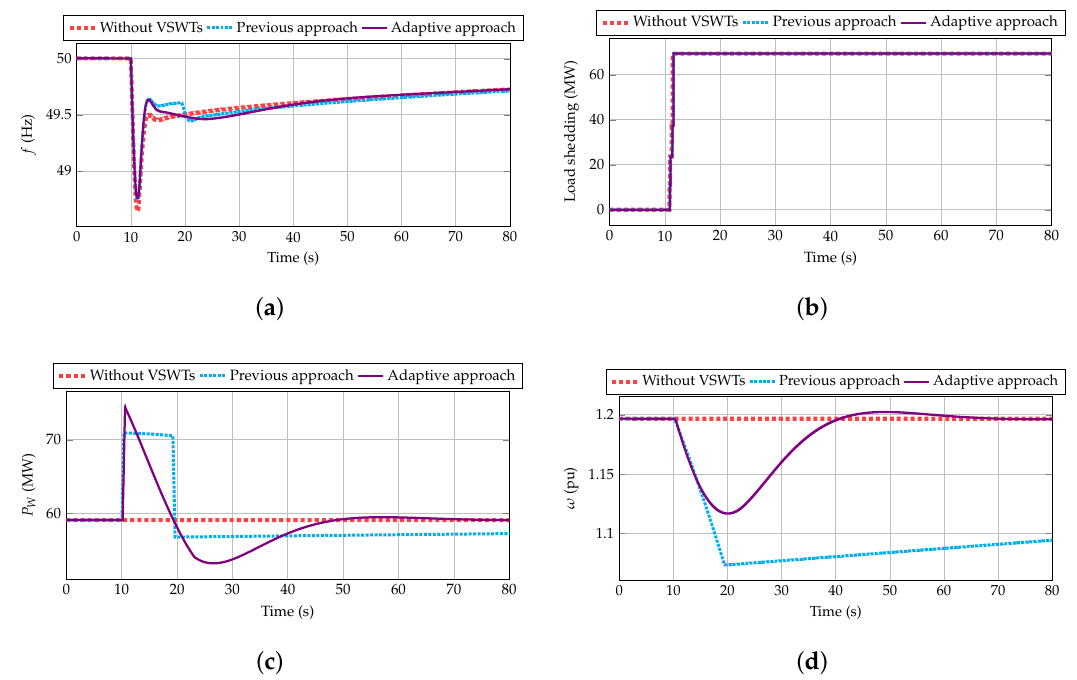
Figure 13. Results for scenario 16 ( a ) Frequency (Hz); ( b ) Load shedding (MW); ( c ) Wind power (MW); ( d ) VSWTs rotational speed